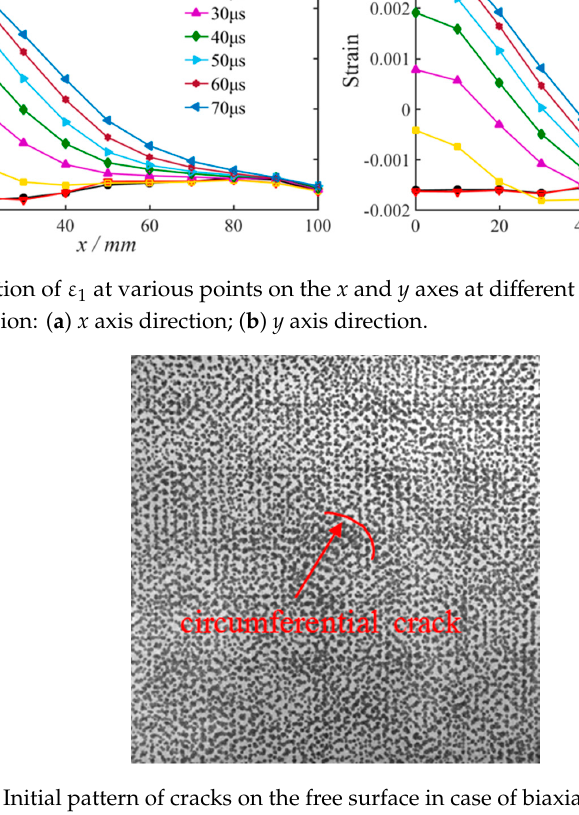
Figure 11. Initial pattern of cracks on the free surface in case of biaxial compression